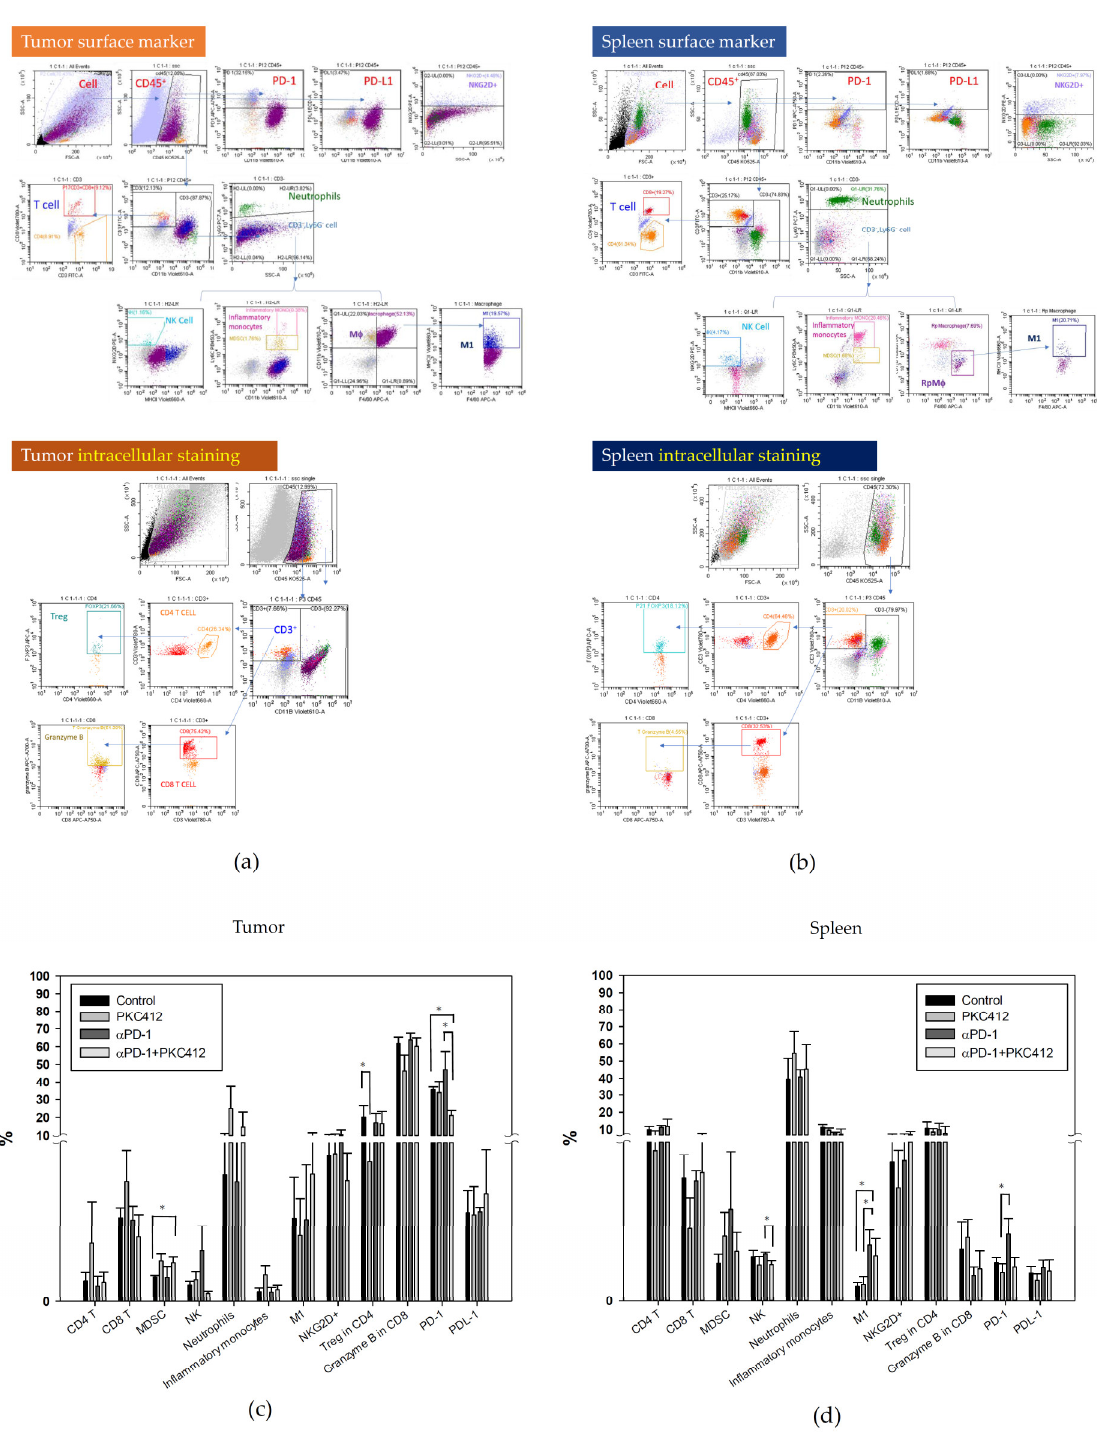
Figure 10. Expression profiles of circulating immune cells in a CT26 syngeneic animal model after monotherapy or combination of midostaurin (PKC412) and anti-PD-1. At the end of the experiment, mice were sacrificed and tumor and spleen specimens were harvested for flow cytometry analysis immune cell expression. The gating strategy of tumor and spleen specimens for flow cytometry analysis was shown ( a , b ). Quantification of immune cell profiles in tumor ( c ) and spleen ( d ) on day 39 after tumor cells implanted in syngeneic BALB/c mice. Data from six mice of each group were expressed as mean ± SEM. Significant differences between control group and PKC412-treated group, or anti-PD-1-treated group and combination-treated group are indicated by * p <